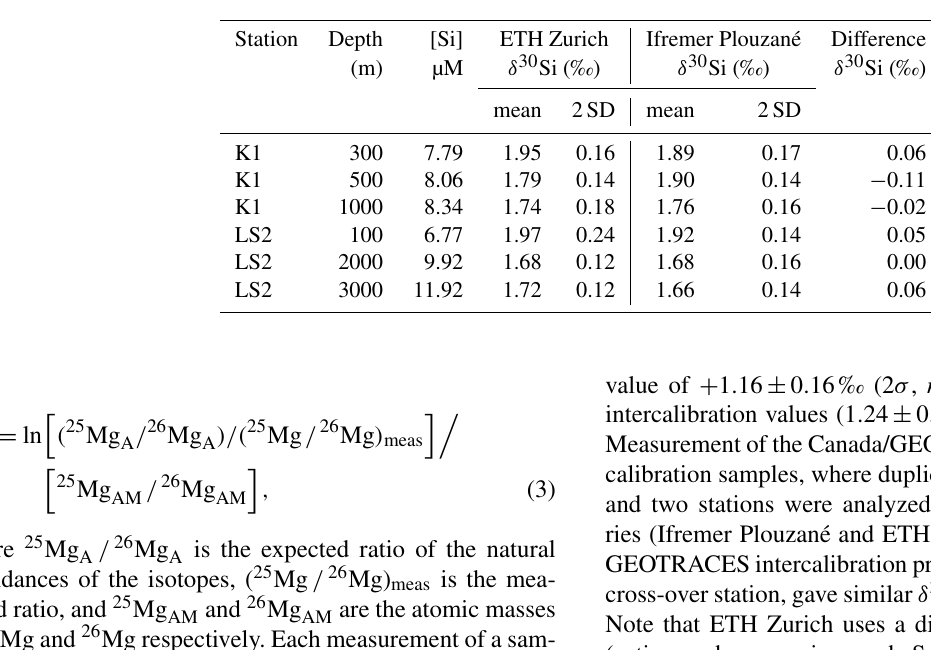
Table 3. Results of the GEOVIDE/Canada GEOTRACES intercalibration exercise for δ 30 Si DSi (‰). Following the GEOTRACES intercal- ibration protocol for a cruise without a cross-over station (i.e., duplicate samples at three depths and two stations; see Table 1 for location details), the mean δ 30 Si ( ± 2 standard deviations; 2SD) was analyzed by two separate laboratories (ETH Zurich and Ifremer Plouzané). The difference in δ 30 Si between the laboratories (values determined for ETH Zurich minus values determined for Ifremer/UBO) is also